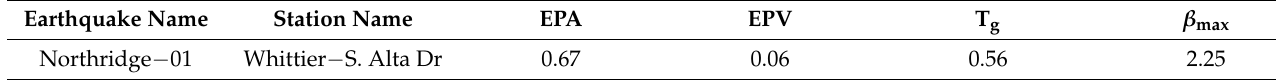
Table 3. Ground motion parameters of natural wave Northridge-01.